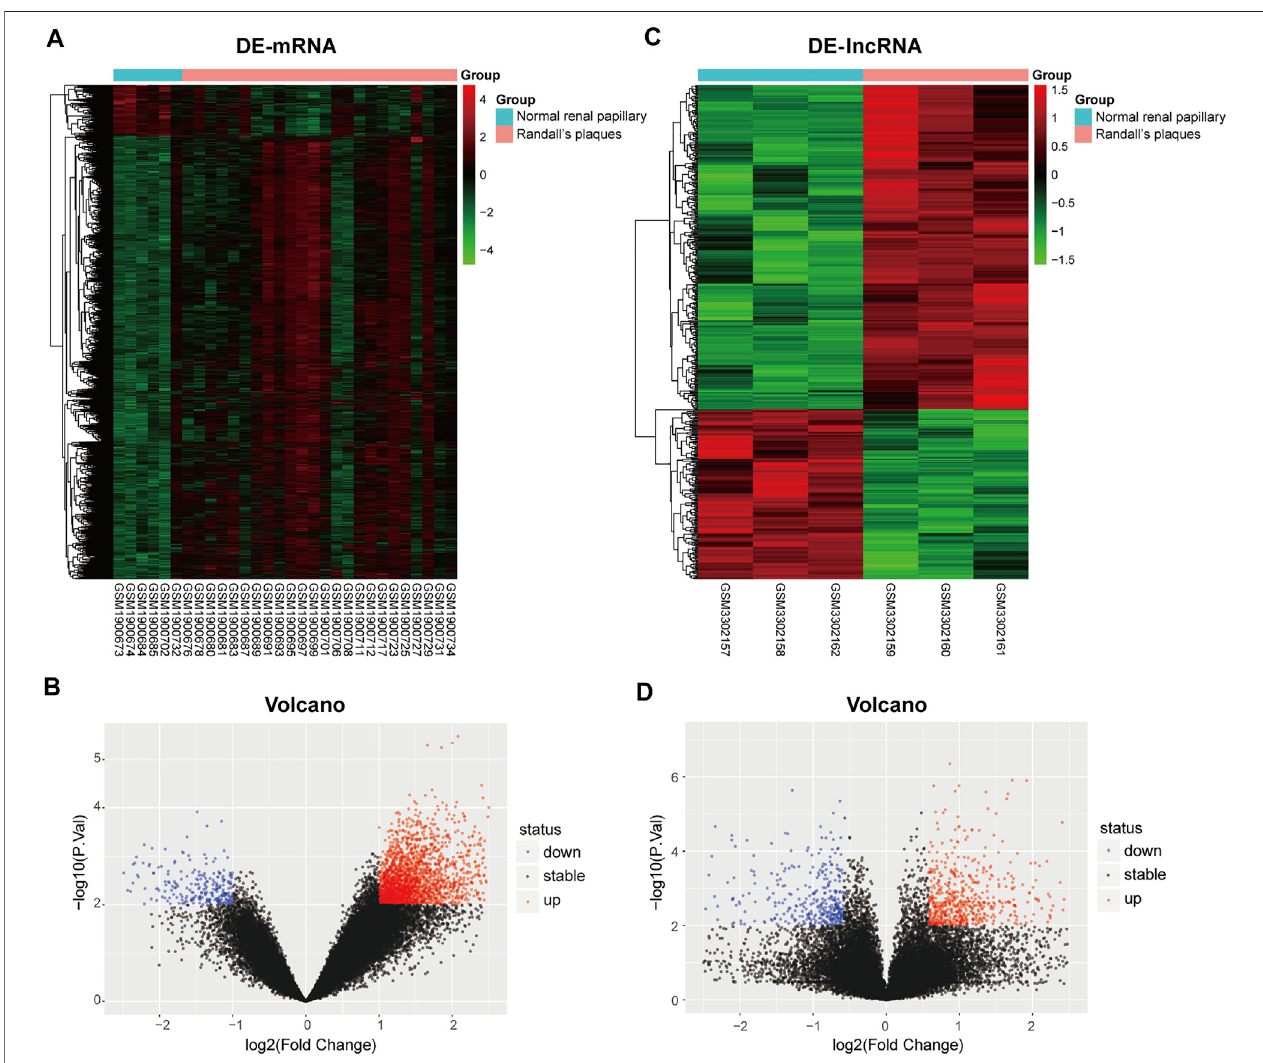
FIGURE 2 | Heatmaps and volcano plots of differentially expressed genes between the Randall ’ s plaques of patients with CaOx kidney stones and normal – renal papillary tissue controls: (A,B) mRNA and (C,D) lncRNA.